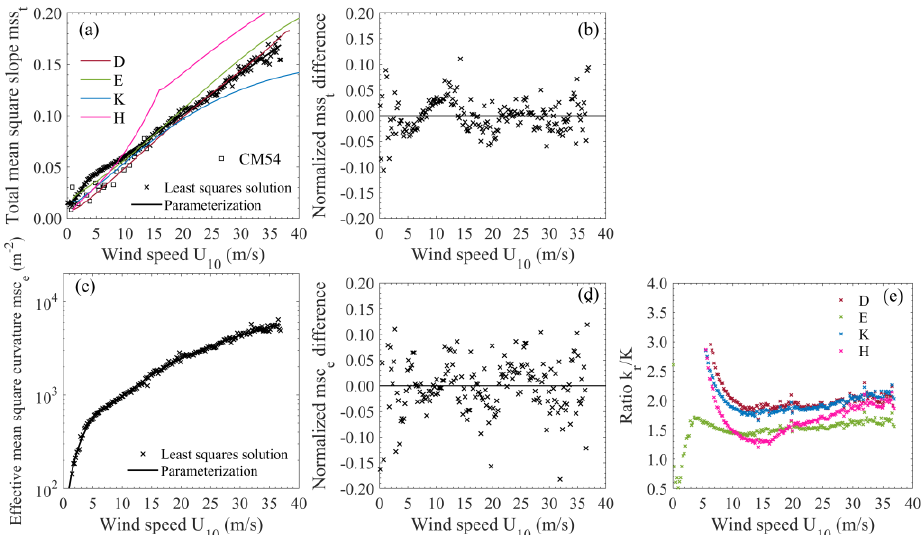
Figure 11. ( a ) Least squares solutions for the total mss with the GO4 model (crosses), the best-fit parameterization (black line), and their comparison with the total mean square slopes from the clean water sun glitter data reported in [9] (squares) and those obtained by integrating the D, E, K, and H spectral functions from zero to 2000 rad / m. ( b ) Parameterization accuracy: Parameterized mss t / mss t – 1. ( c ) Solutions for the e ff ective msc (crosses) and the best-fit parameterization (black line). ( d ) Parameterization accuracy: Parameterized msc e / msc e – 1. ( e ) Ratio of the high-limit cuto ff wave number k r to K versus wind speed. Colors for D, E, K, and H spectra are the same as those in Figure